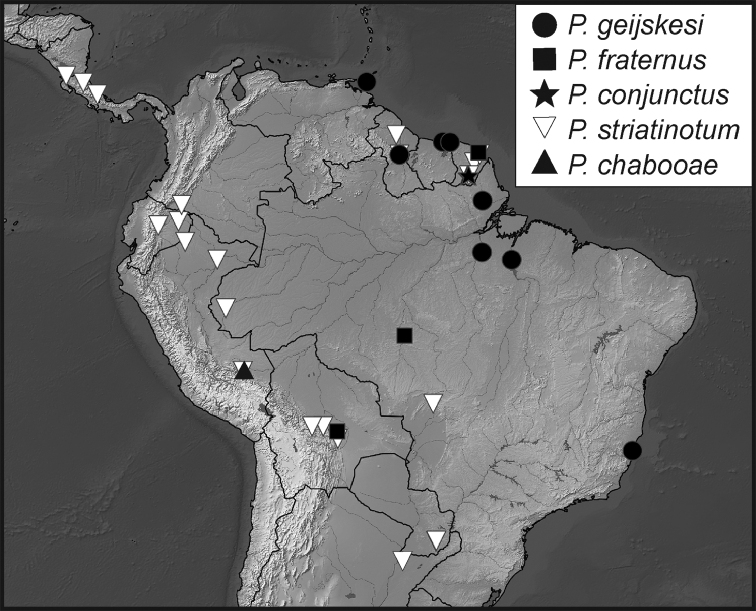
Collecting records for Phelister
geijskesi (circles), P.
fraternus (squares), P.
conjunctus (star), P.
striatinotum (inverted triangles), and P.
chabooae (upright triangle).